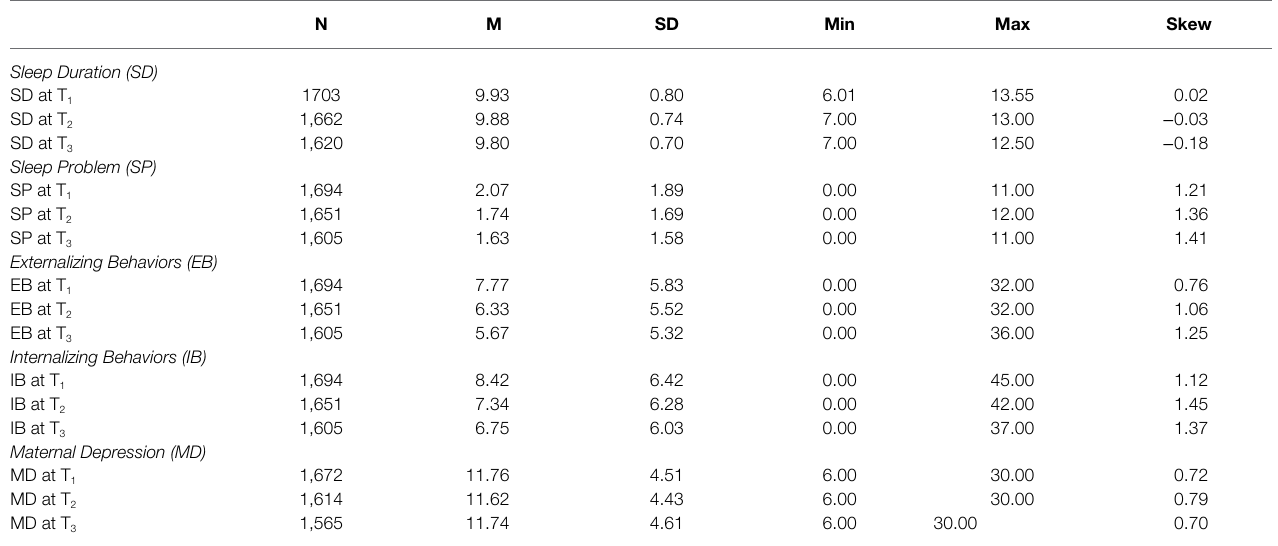
TABLE 1 | Descriptive statistics on children’s sleep and adjustment and maternal